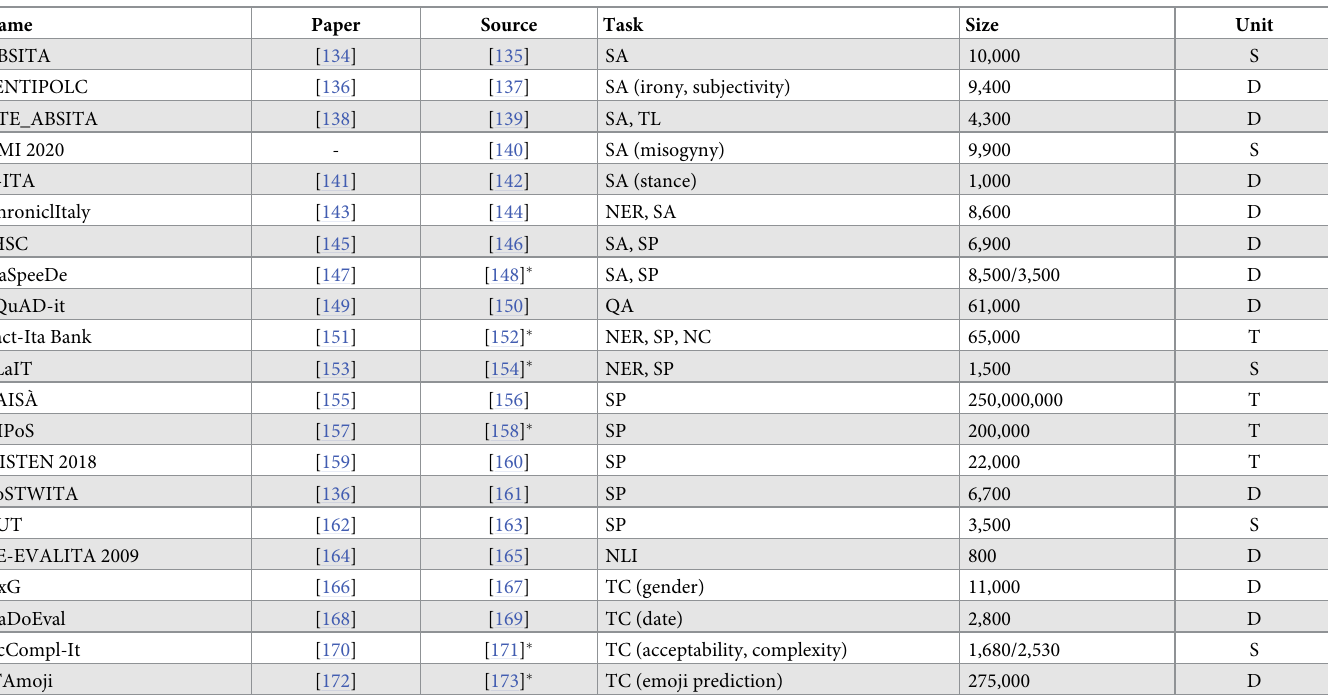
Table 4. Italian datasets.